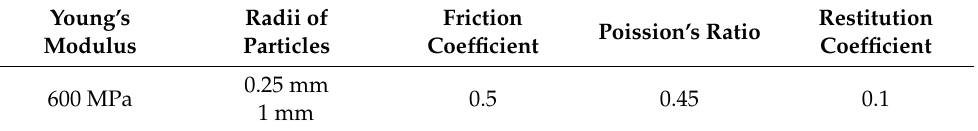
Table 2. Properties of particles.